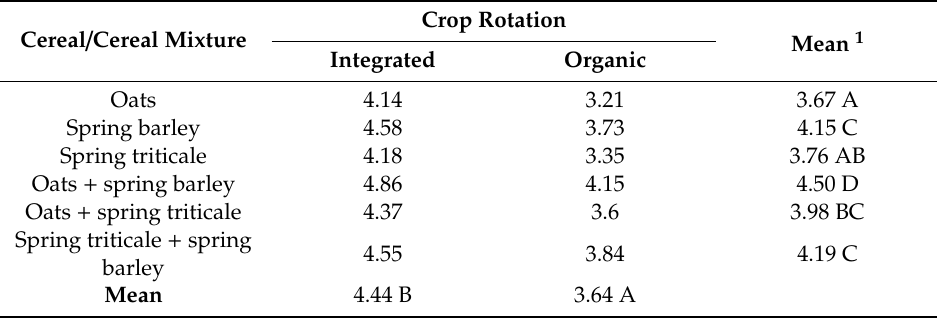
Table 4. Grain yield (t ha − 1 ) of spring cereals grown in pure sowings or in mixtures in integrated or organic crop rotation, means for the years 2011–2019.